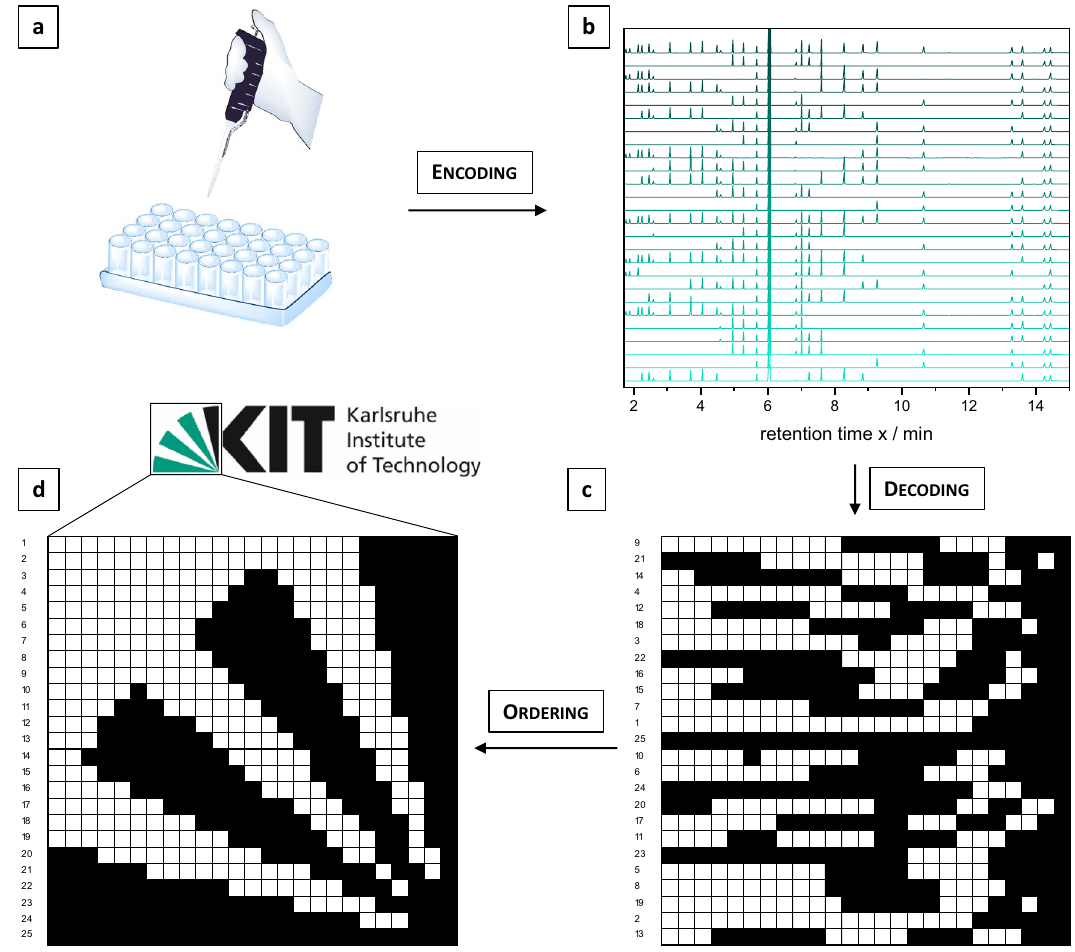
Figure 2. Schematic representation of bitmap coding. ( a ) Production of mixtures of up to 25 information- containing compounds per sample (25 bits) plus two reference molecules. ( b ) Randomly stacked, as obtained, GC chromatograms of information-containing samples plus reference chromatogram containing all compounds. ( c ) Translation of chromatograms into 25 × 25-pixel bitmap via alignment principle with the reference chromatogram. The absence of a signal is translated into a white pixel and the presence into a black pixel. The signals for the internal standard and the “ordering” compound were excluded from the translation process. ( d ) Ordering of the pixel lines according to the integral ratio of the two reference signals (Supplementary Fig. 4) revealing a picture of a fan, which symbolizes the fan shape of the city Karlsruhe and is also part of the KIT logo. The KIT logo was copied and modified with permission of the KIT. © Karlsruhe Institute of